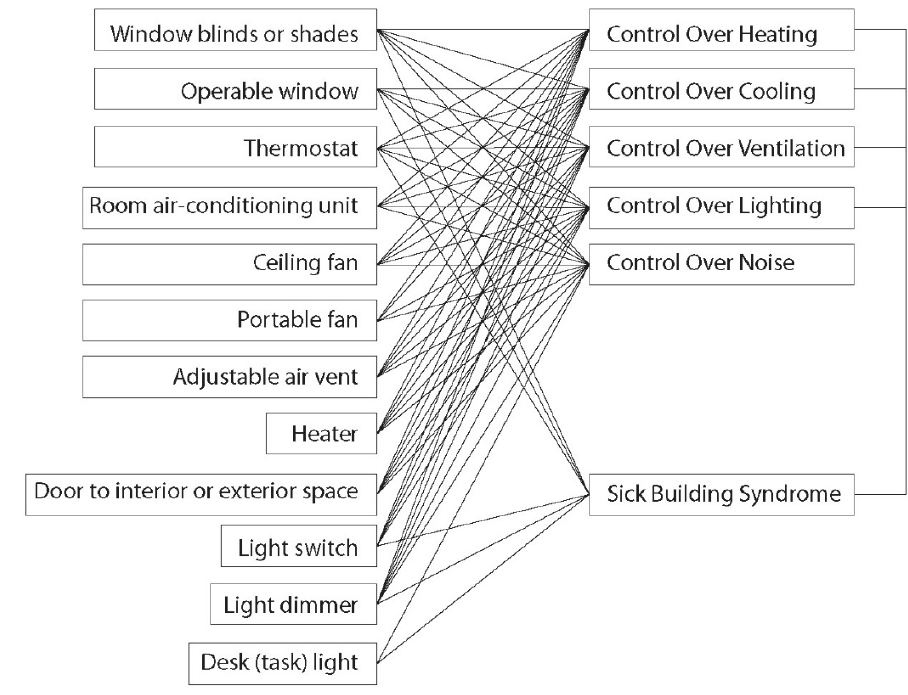
Figure 1 Relationship and effectiveness. Figure 1. Relationship and